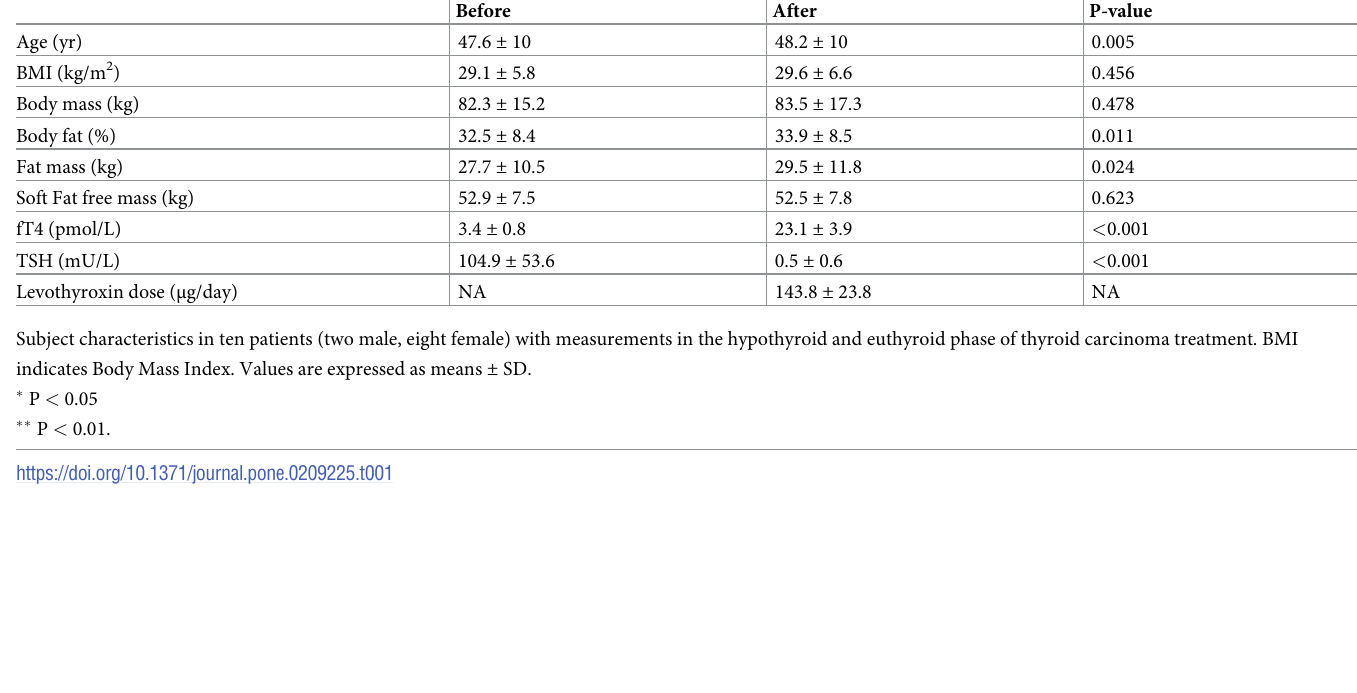
Table 1. Subject characteristics (n = 10).